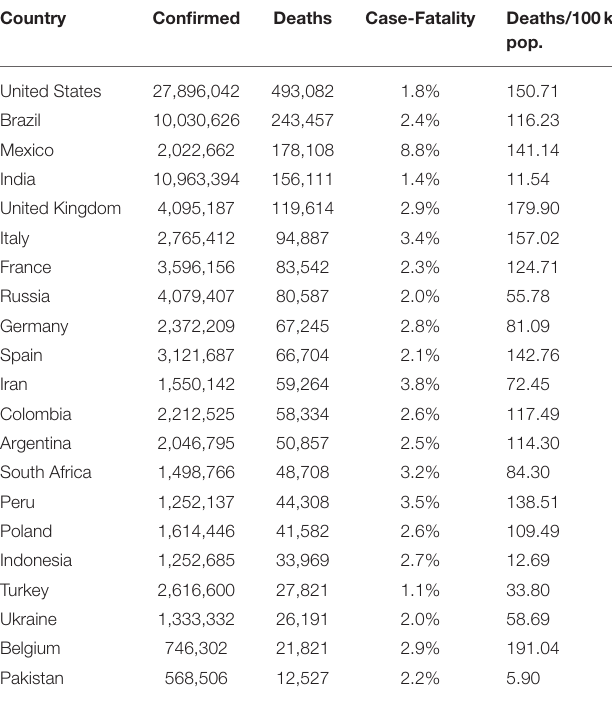
TABLE 3 | COVID-19: case mortality analysis - deaths worldwide (February 19, 2021).